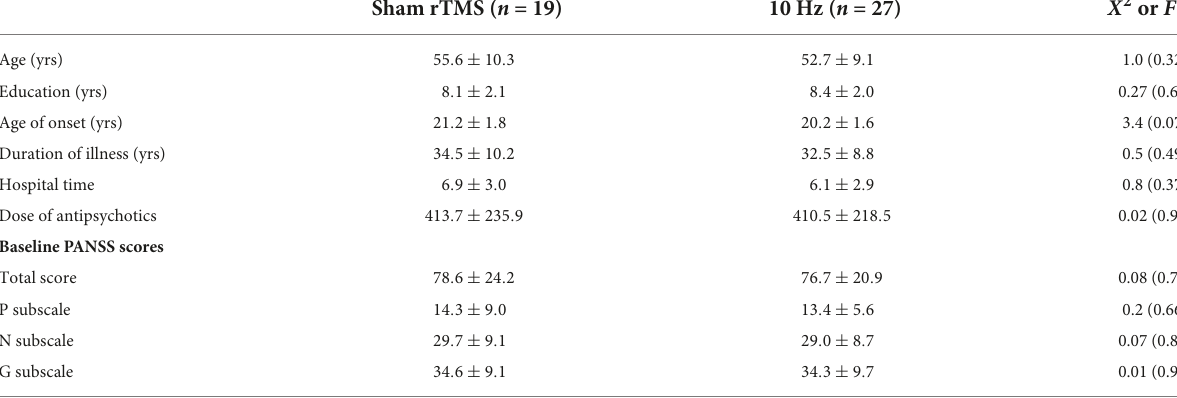
TABLE 1 Demographic and clinical data of active and sham rTMS groups at baseline.